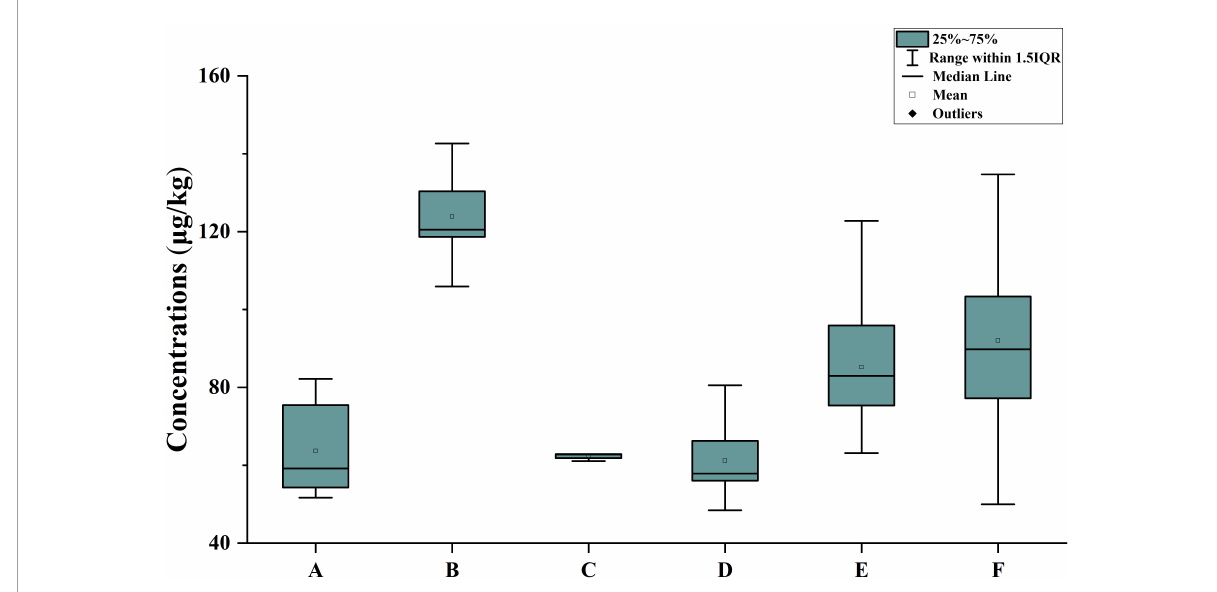
FIGURE5 Measured concentrations of (cid:54) POE-tallowamine in citrus samples from different typical regions. A: Guangxi province, Shatang mandarin, B: Zhejiang province, Jelly orange, C: Hunan province, Bingtang sweet orange, D: Chongqing municipality, Satsuma mandarin, E: Chongqing municipality, Orah citrus, and F: Chongqing municipality, W. Murcott